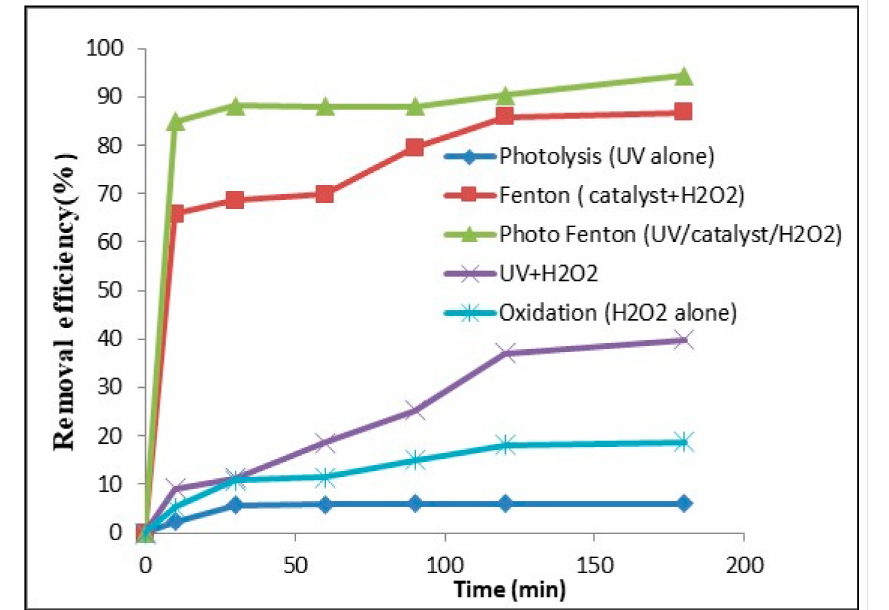
Figure 5. CV dye removal under different tested processes.